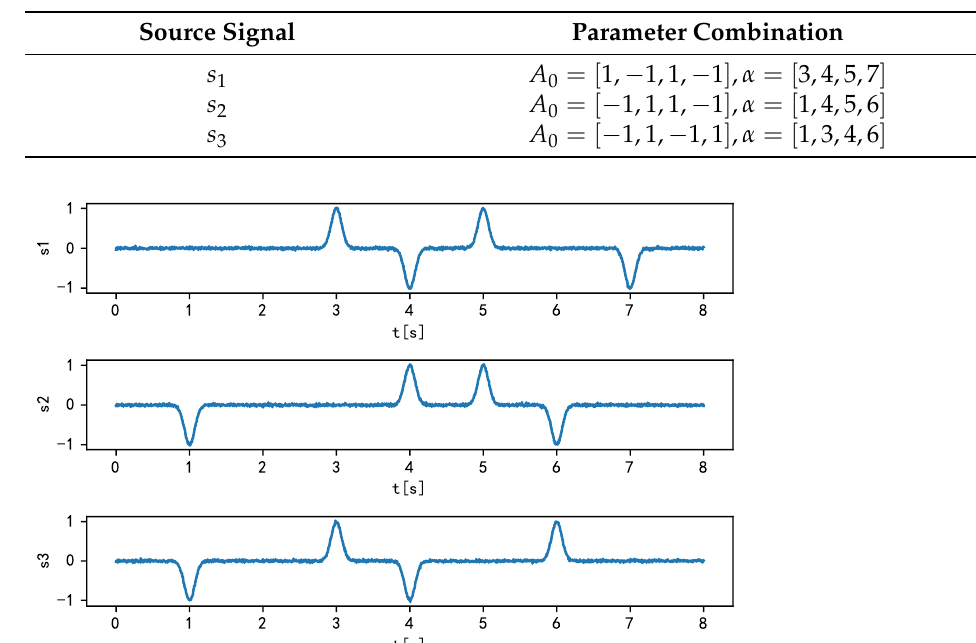
Table 8. Parameter configuration of sparse source signals.